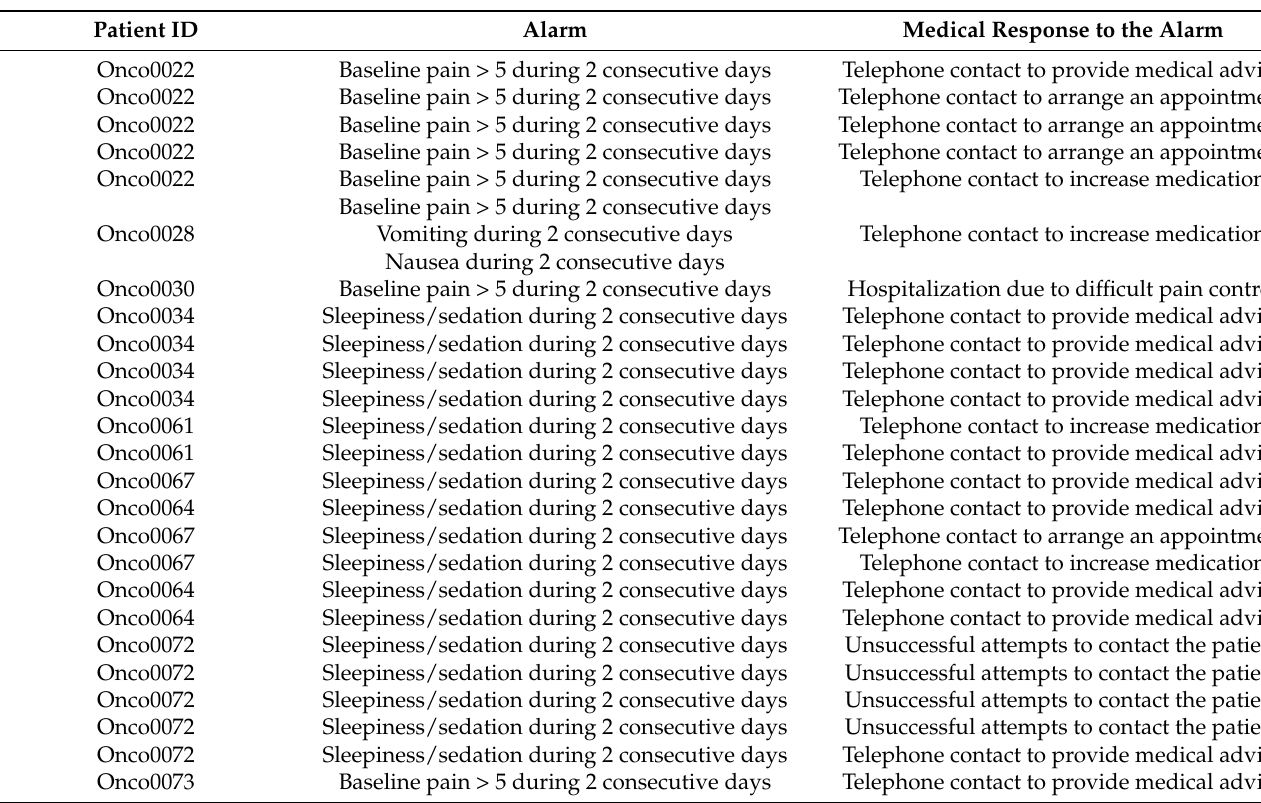
Table 3. Description of alarms detected by the app and the response to them by the medical